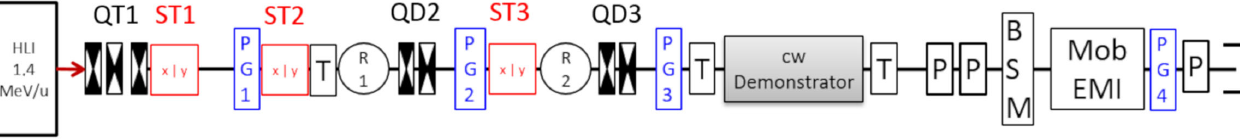
FIG. 1. Demonstrator Environment 2018. QT: Quadrupole Triplet, QD: Quadrupole Duplet, R: Rebuncher, x|y: Beam Steerer, PG1-4: SEM-Grid, T: Beam Current Transformer, P: Phase Probe, BSM: Bunch Shape Monitor, EMI: Emittance Meter